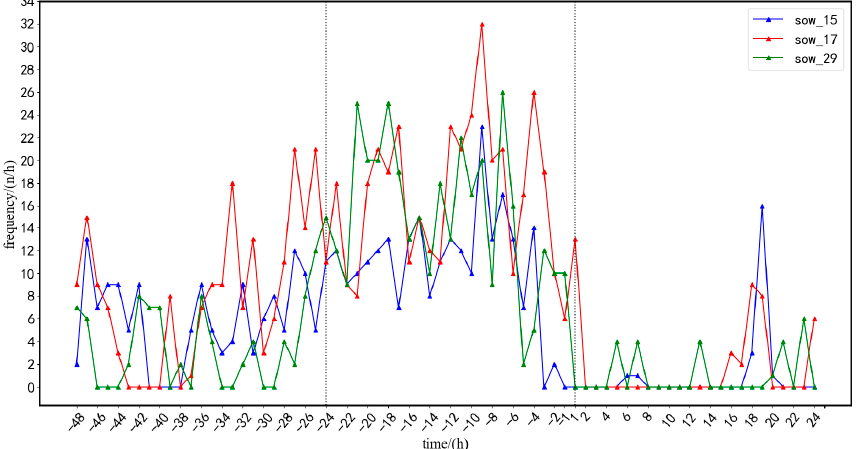
Figure 11. Visualization of the frequency of sow posture change (three sows are taken for example).